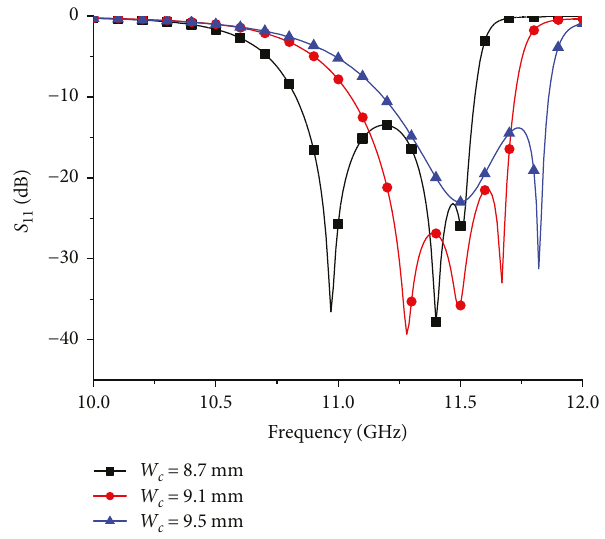
Figure 6: The scattering parameters versus frequency with variable W ( W =26.8mm, S c s